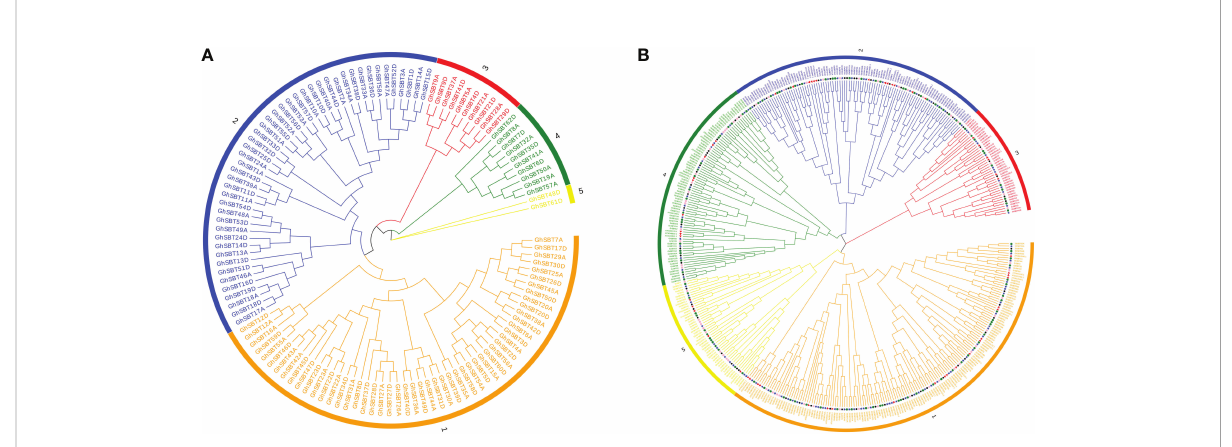
FIGURE 1 Two unrooted phylogenetic trees of SBT genes were constructed by MEGA7: the evolutionary tree of the GhSBT family was constructed using the neighbor-joining method, and the interspeci fi c evolutionary tree of SBTs was constructed using the maximum likelihood method. (A) Phylogenetic tree of the SBT family protein sequences in upland cotton; (B) Phylogenetic relationships of 422 SBT proteins from G. hirsutum, G. barbadense, G. arboreum, G. raimondii , and Arabidopsis